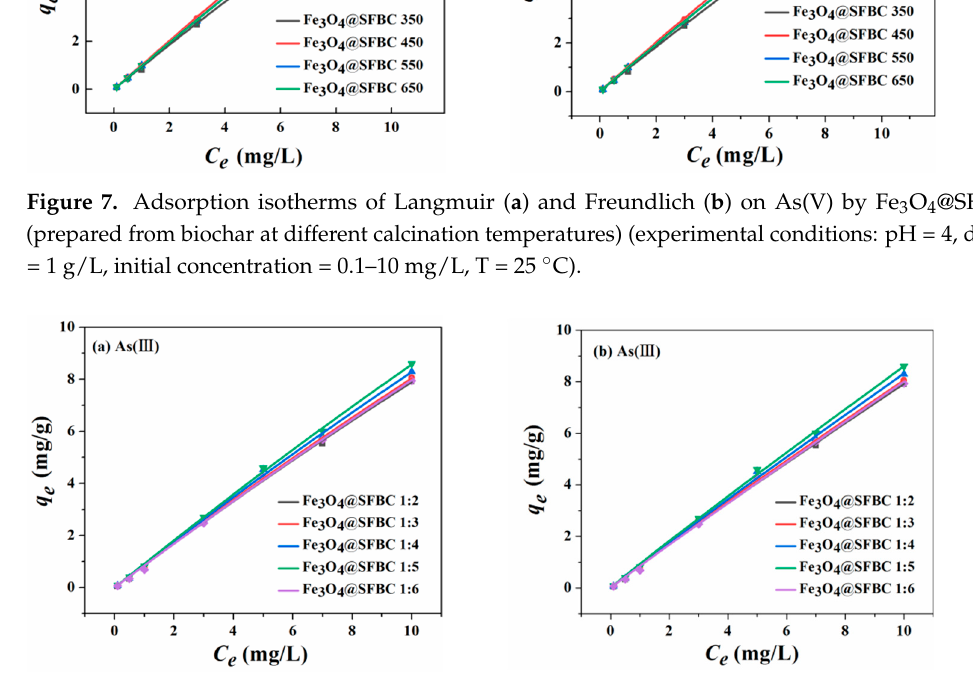
Figure 8. Adsorption isotherms of Langmuir ( a ) and Freundlich ( b ) on As(III) by Fe 3 O 4 @SFBC (different SFBC/Fe mass ratios) (experimental conditions: pH = 6, dose = 1 g/L, initial concentration = 0.1–10 mg/L, T = 25 °C).